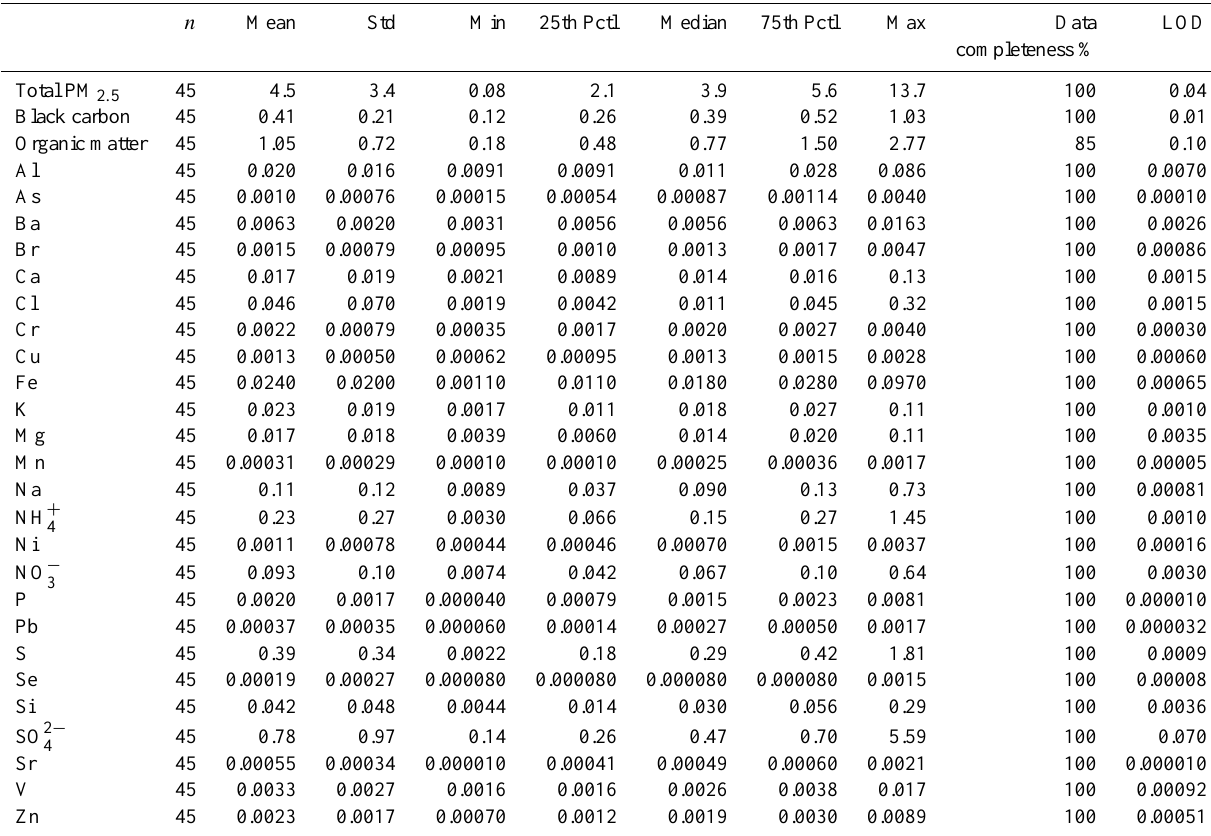
Table 3. Descriptive statistics of PM 2 . 5 mass (µgm − 3 ) and species mass (µgm − 3 ) used in the PMF